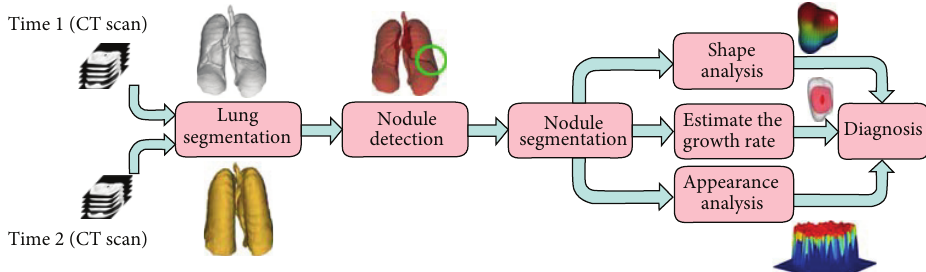
Figure 1: Typical computer-aided diagnosis (CAD) system for lung cancer. The input of a CAD system is the medical images obtained using an appropriate modality. A lung segmentation step is used to reduce the search space for lung nodules. Nodule detection is used to identify the locations of lung nodules. The detected nodules are segmented. Then, a candidate set of features, such as volume, shape, and/or appearance features, are extracted and used for